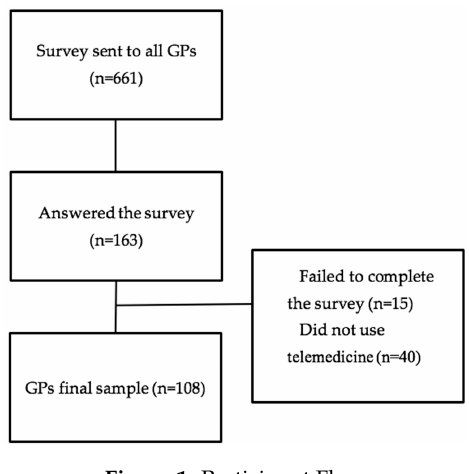
Figure 1. Participant Flow.